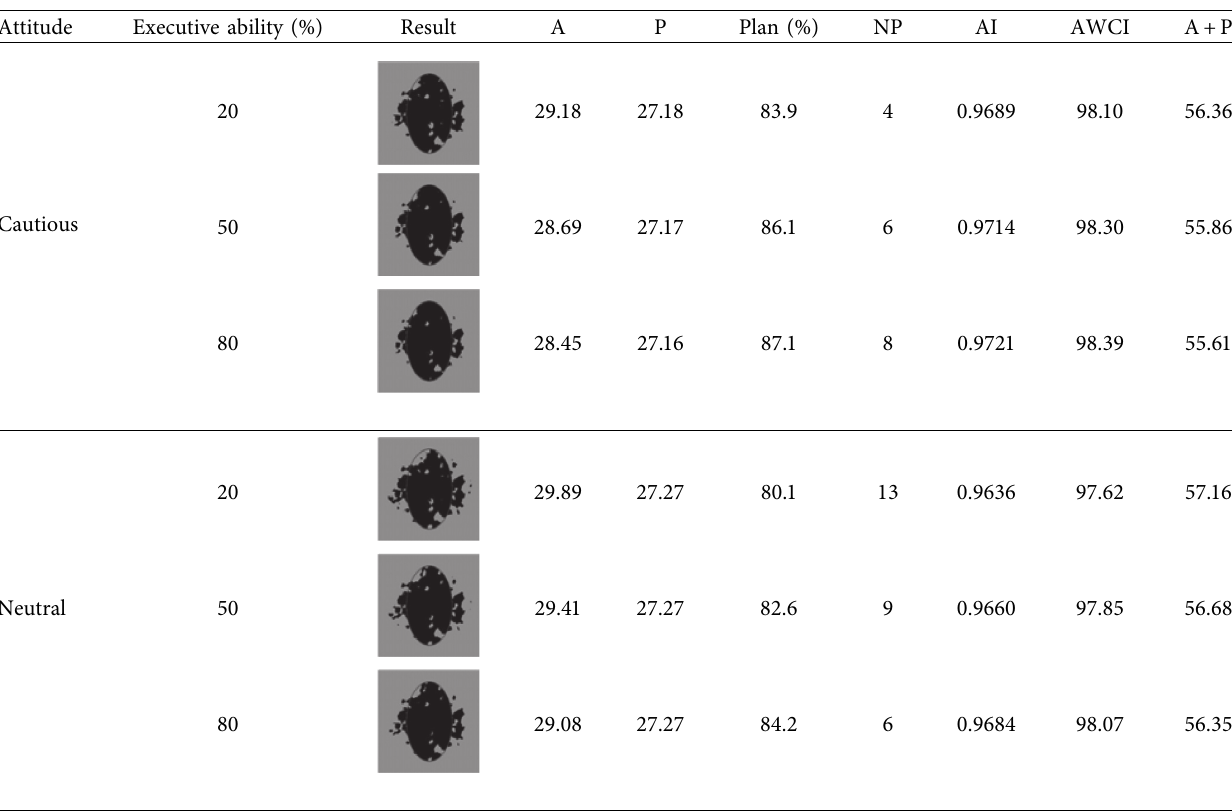
Table 2: Results of land development in the situation of planning coordinating with the city’s self-organizing